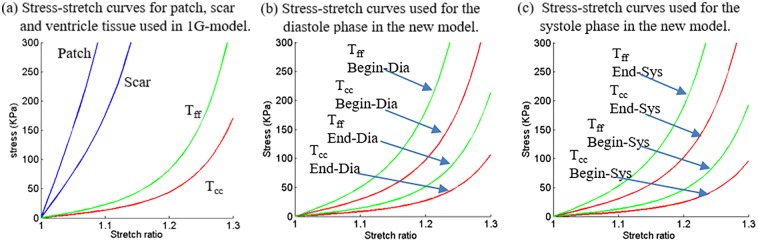
Material Stress-Stretch curves used for the new 2G and old 1G models.(a) Stress-stretch curves for patch, scar and ventricle tissue used in 1G model; (b) stress-stretch curves used for the diastole phase in the 2G model; (c) stress-stretch curves used for the systole phase in the 2G model. Tff: stress in fiber direction; Tcc: stress in cross-fiber direction.